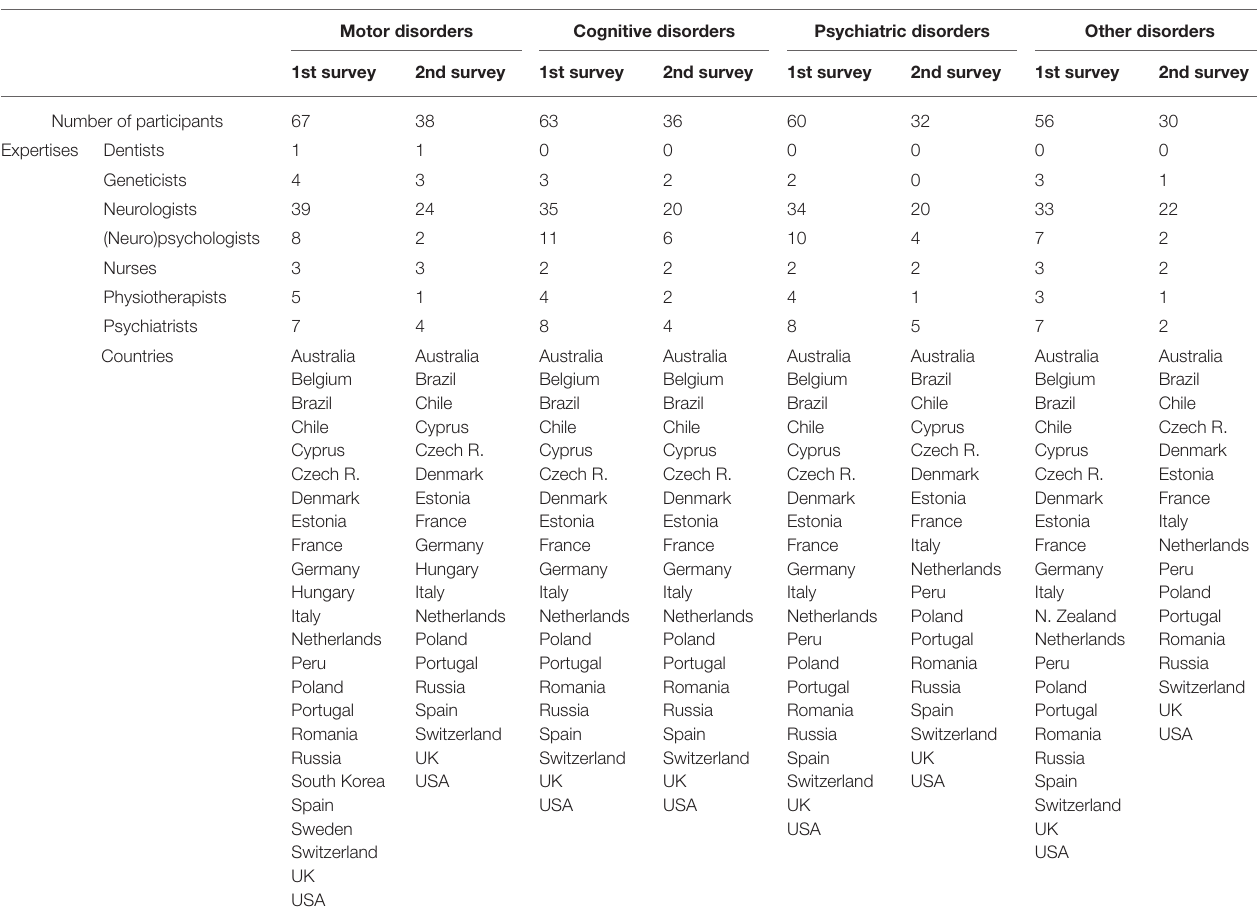
TABLE 2 | Composition of the international multidisciplinary HD health